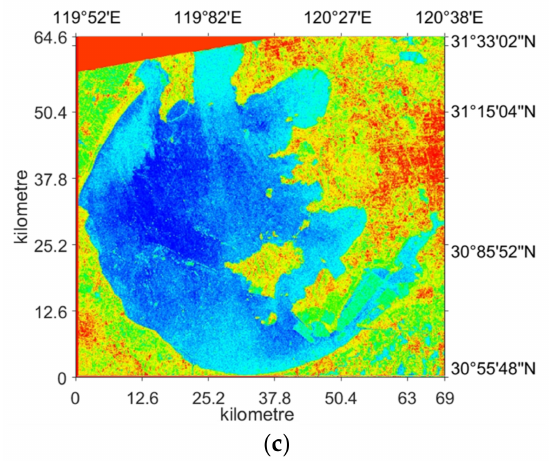
Figure 6. A pair of optical and SAR images of Taihu Lake: ( a ) Acquired Landsat-8 image on 11 September 2015; ( b ) acquired Sentinel-1A image on 11 September 2015; and ( c ) false color image of ( b ).